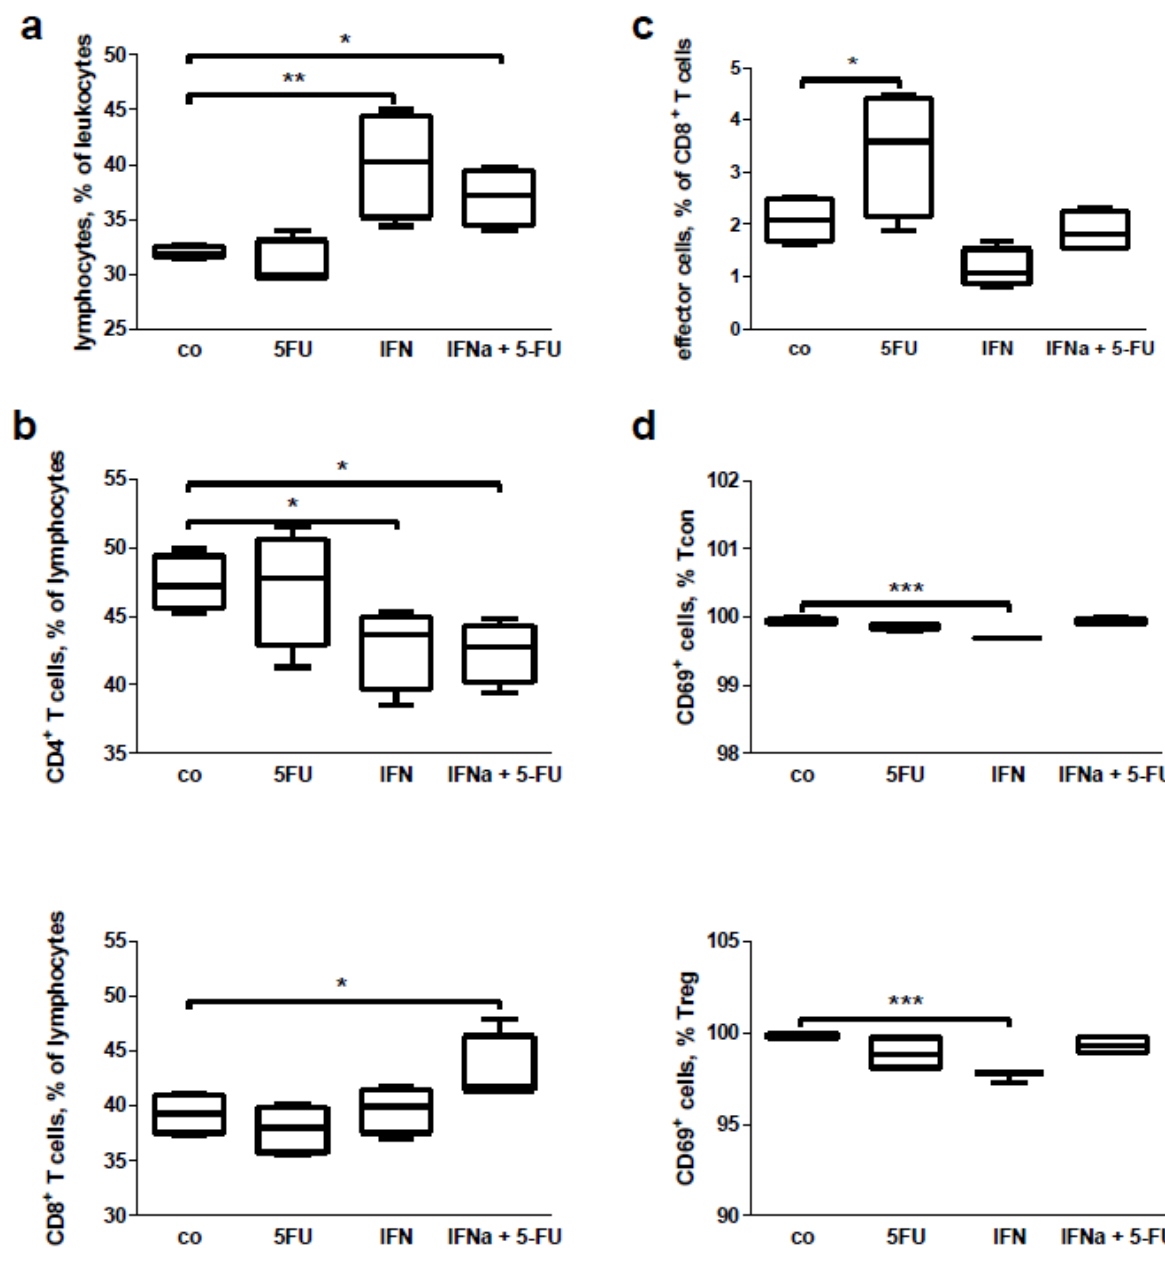
Figure 7. In vitro effects of therapies with IFN or 5-FU treatment only or their combination on splenocytes from tumor-bearing mice: FACS analysis of ( a ) lymphocytes; ( b ) CD4 + and CD8 + lymphocytes; ( c ) CD8 + effector cells; ( d ) CD69 expression on the surface of Tcon and Treg. Results of four independent experiments are presented, * p < 0.05, ** p < 0.01 and *** p < 0.001, co—control treated